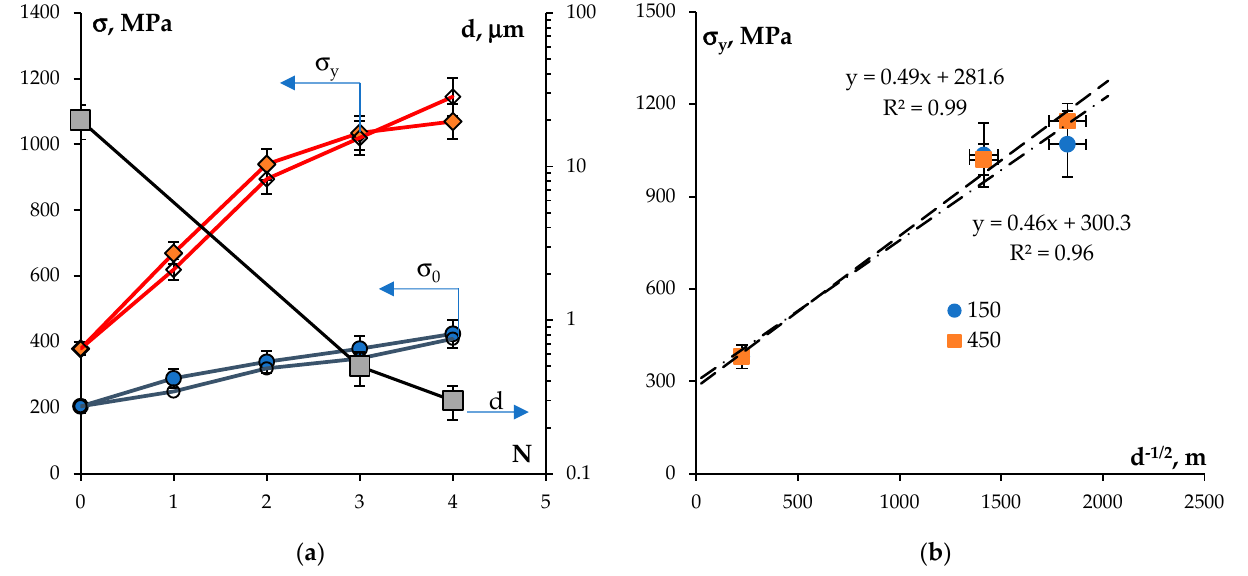
Figure 8. Results of investigations of mechanical properties of UFG steel ( Т ECAP = 450 °C): ( a ) de- pendencies of mean grain sizes and mechanical properties of steel on the number of ECAP cycles; ( b ) dependence of the yield strength on grain size on σ y -d − 1/2 axes.